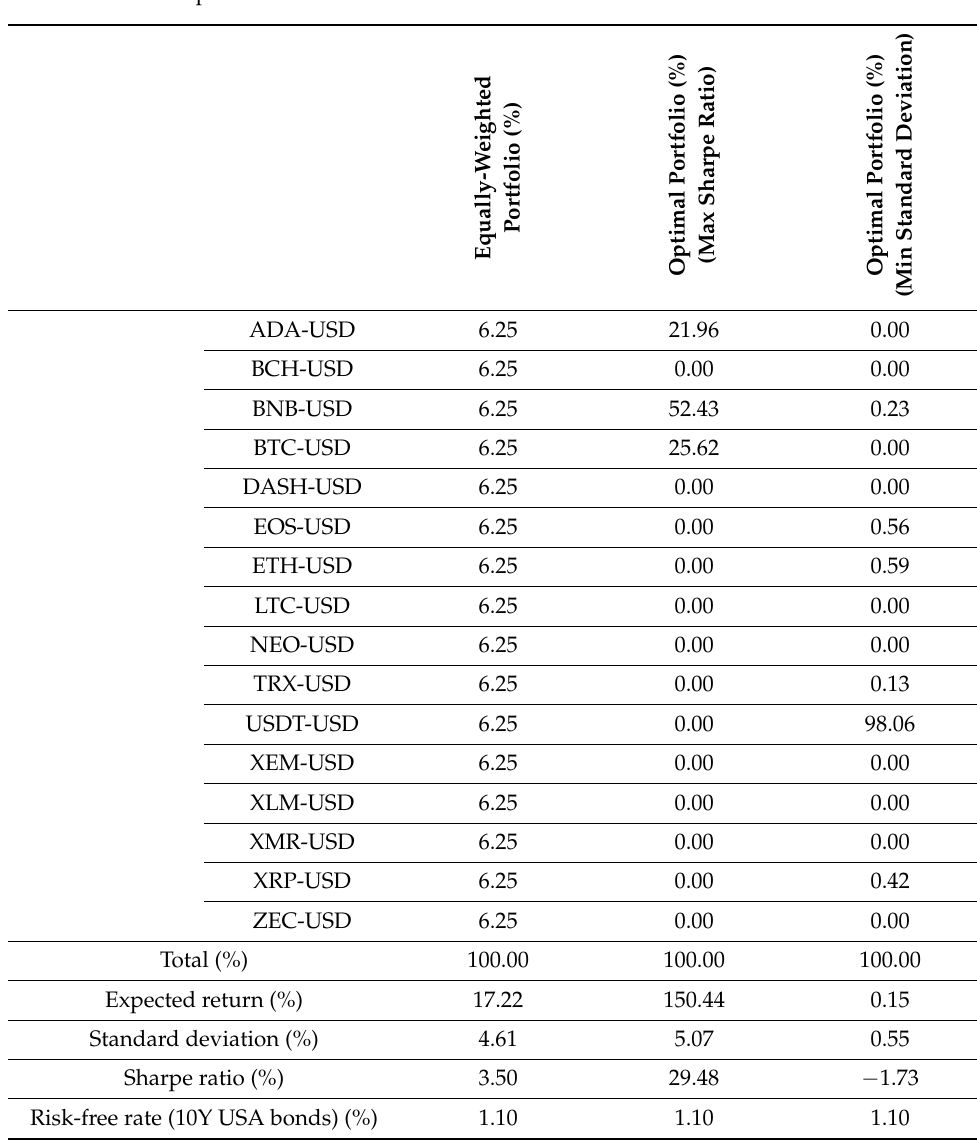
Table 4. Results of portfolio